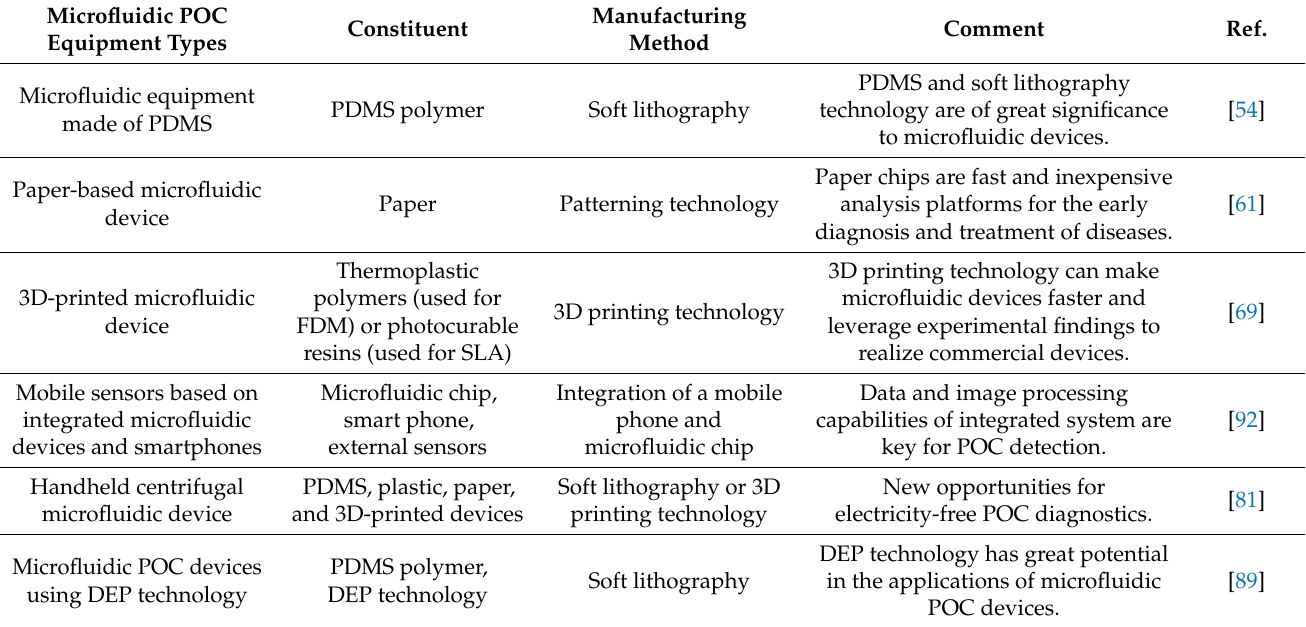
Table 1. The overview of microfluidic POC equipment